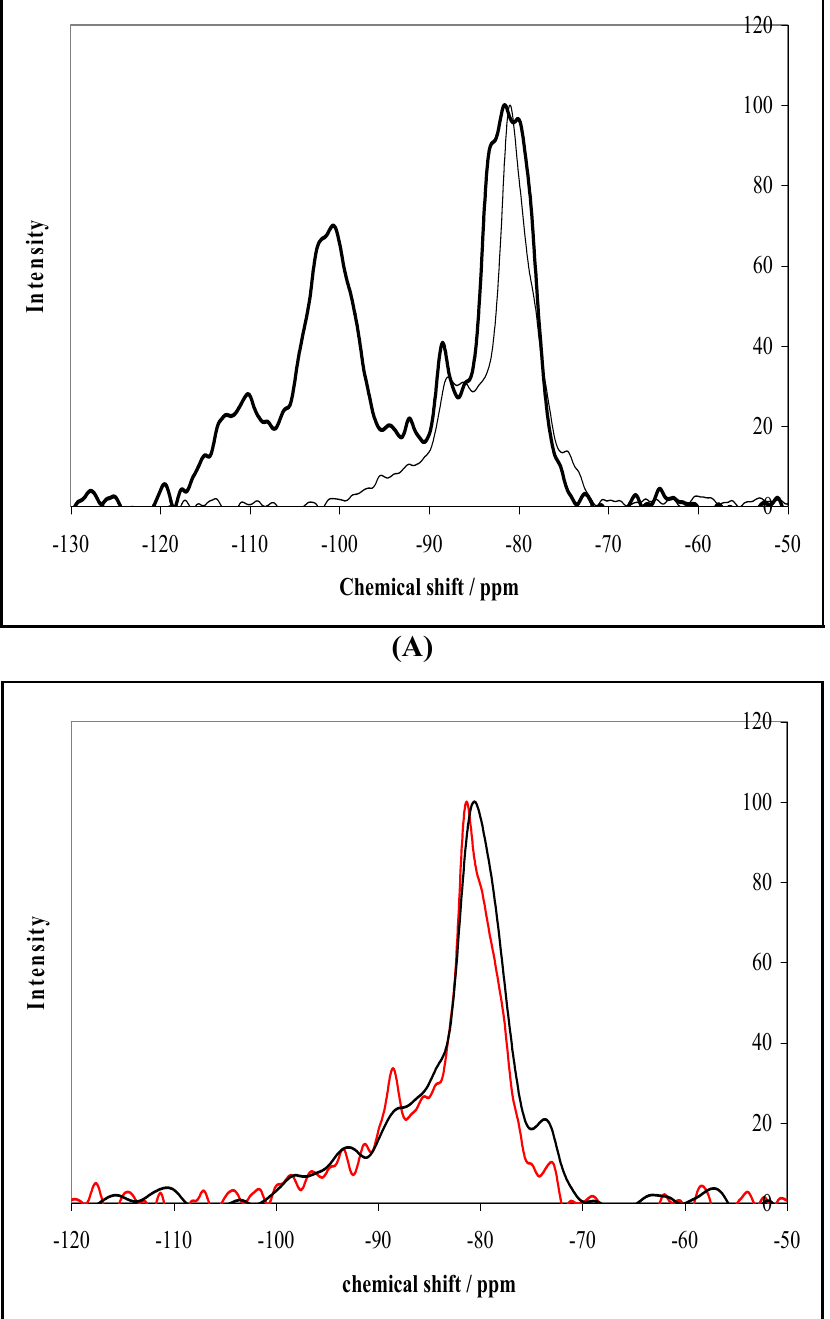
Figure 2. ( A ) Comparison of 29 Si MAS n.m.r. spectra of a 5 wt% silica-95% TiO mix (thick line) and a 5 wt% silica-TiO Iler’s “dense silica” method (series 2S); ( B ) N.m.r. of 3.2 wt% silica-TiO after (black) heat treatment at 450°C (series